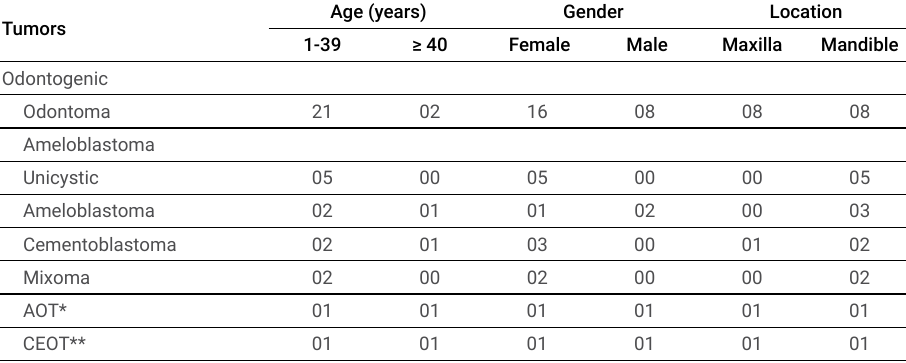
Table 3. Distribution of odontogenic and non-odontogenic tumors according to age, gender and location, CRLB, UEFS, 2006-2018.